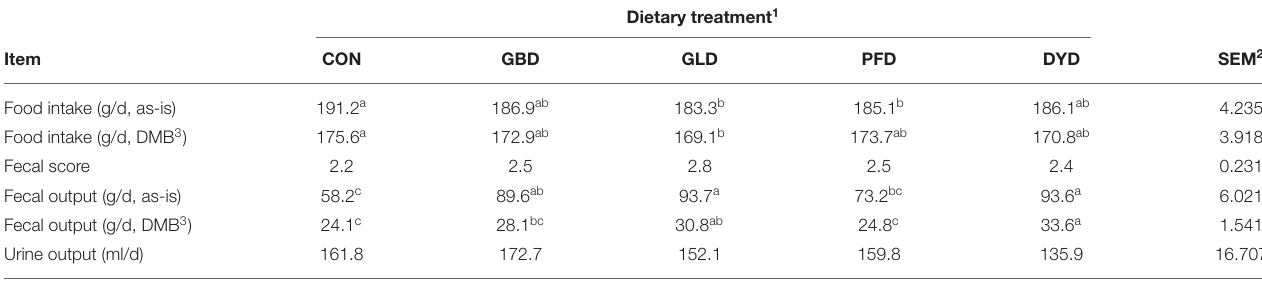
TABLE 3 | Food intake, fecal scores, and fecal output of dogs fed diets containing legumes or yeast as the primary protein source.